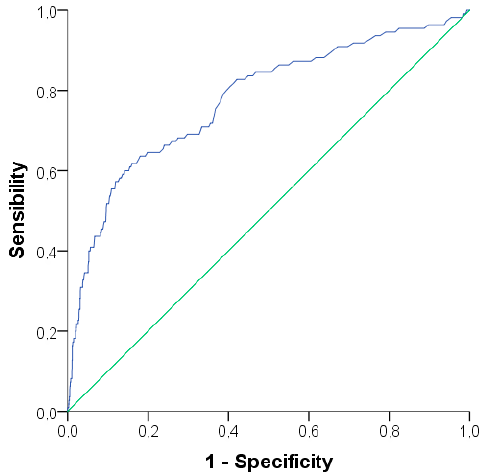
Figure 1. Receiver Operating Characteristics curve for predicting elevated alanine transaminase levels (>25 UI/L in women and >33 UI/L in men) with triglyceride values. Area under the curve: 0.777 (CI 95% 0.726–0.827; p < 0.001). Triglycerides levels of 129.5 mg/dL provide a sensitivity of 64.5% and specificity of 80.2%.